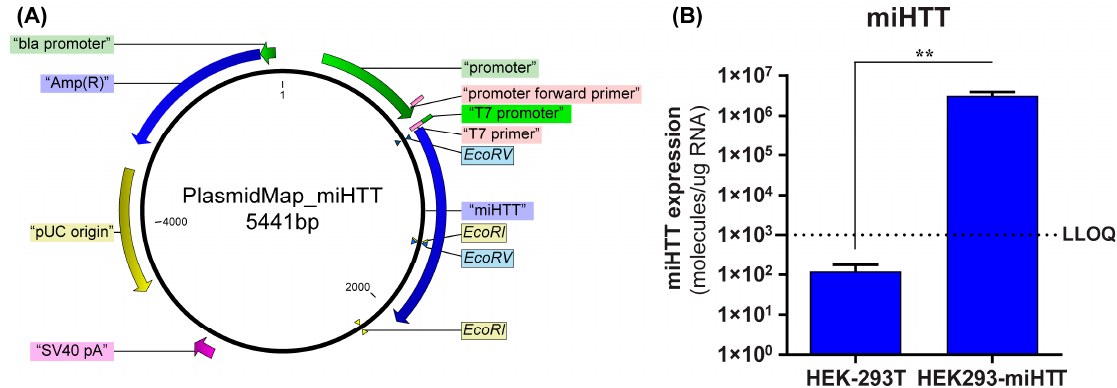
Figure 2. Generation of HEK293-miHTT—a stable cell line overexpressing miHTT. ( A ) Plasmid map of the miHTT sequence cloned into pcDNA™5/FRT plasmid. ( B ) miHTT detection in wild-type HEK- 293T (negative control) and in the HEK293miHTT stable cell line. ≥ N = 6 repeats per experimental condition. LLOQ, lower limit of quantification. (** p < 0.01).